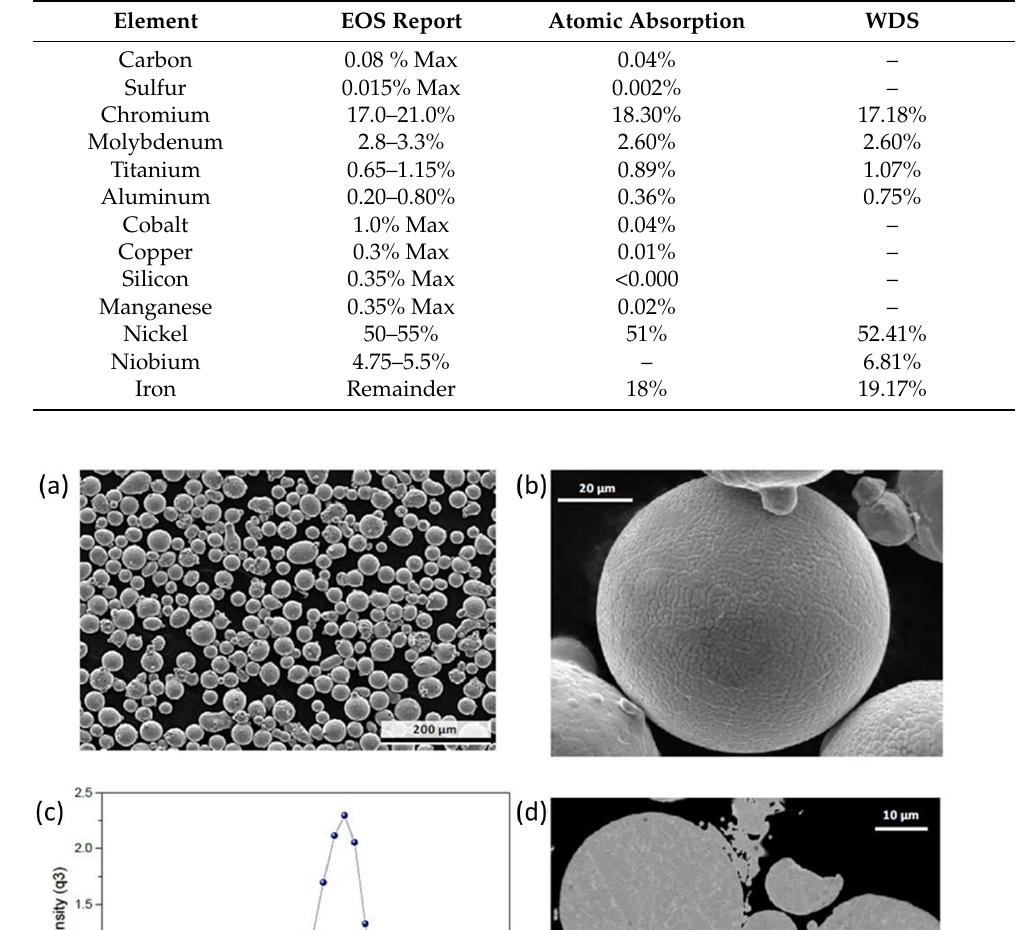
4 of 15 Figure 1. Cellular architecture of the samples. IN718 pre-alloyed powders produced by gas atomization (EOS GmbH, Krailling/Mu- nich, Germany) were used as feedstock. The chemical composition of the IN718 powder